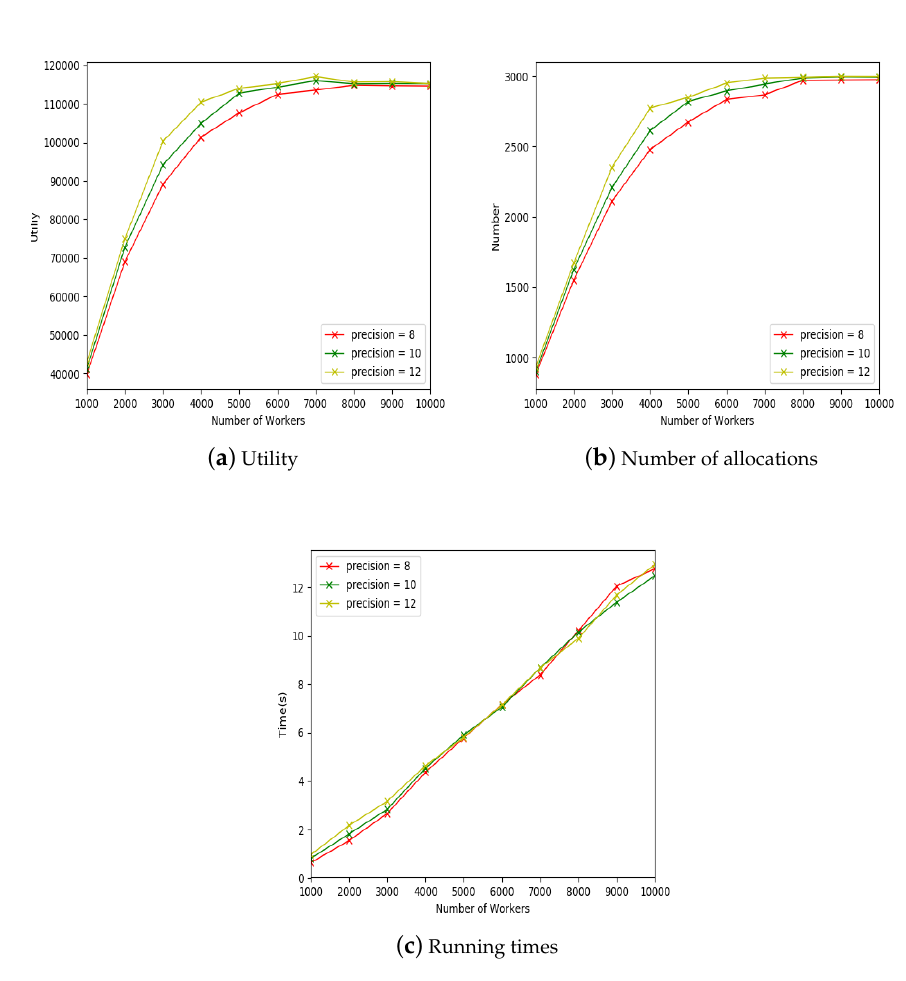
Figure 6. The effect of